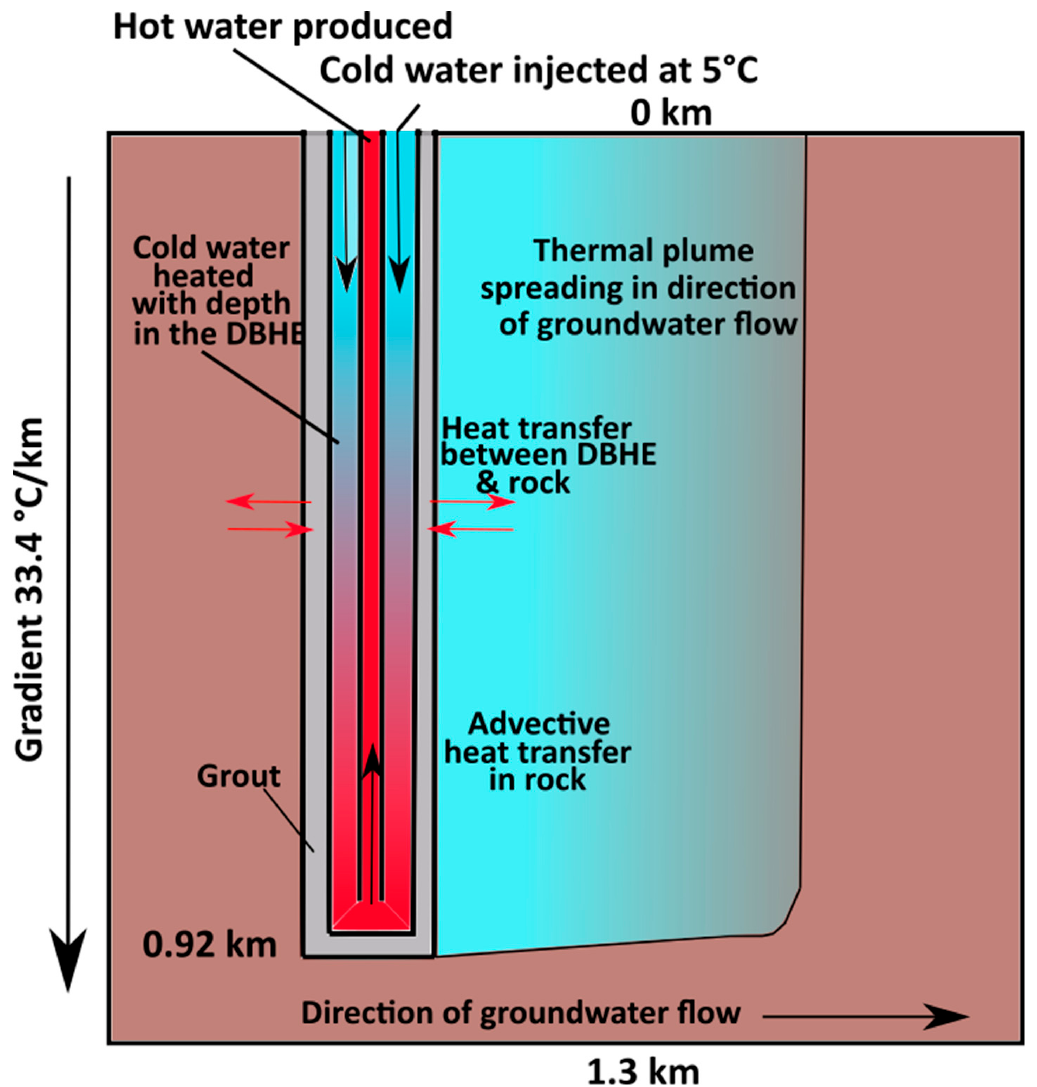
Figure 1. DBHE schematic with cold plume created during extraction (modified from [1]).